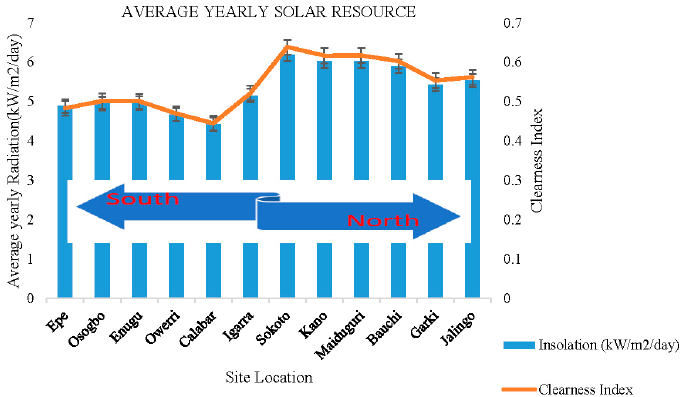
Figure 1. Yearly solar resource.